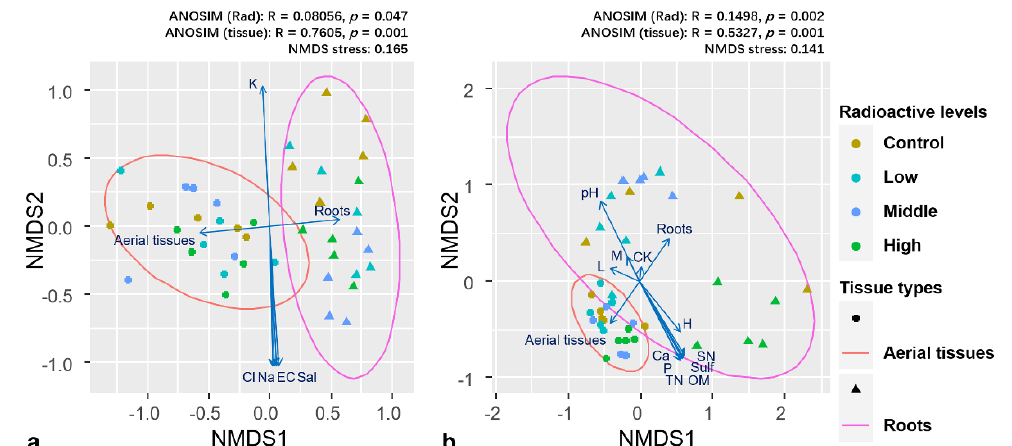
Figure 3. NMDS ordination indicated the difference in composition of bacterial ( a ) and fungal ( b ) communities between aerial tissues and roots, and across control and three radiation levels. ANOSIM analysis indicated that both bacterial and fungal communities were significantly different when grouped no matter with radiation levels or with tissue types. Arrows indicated environmental factors and vectors fit to NDMS ordination with significance at 0.05 level. C, L, M, and H at arrows represented control, low, medium, and high level ionizing radiation treatments, respectively. Abbreviations for environmental features: EC, electrical conductivity; OM, organic matter; TN, total nitrogen; SN, soluble nitrogen; P, available phosphorus; K, available potassium; Sal, salt; Cl, chloride ion; Sulf, sulfate; Ca, calcium ion; Na, sodium ion.